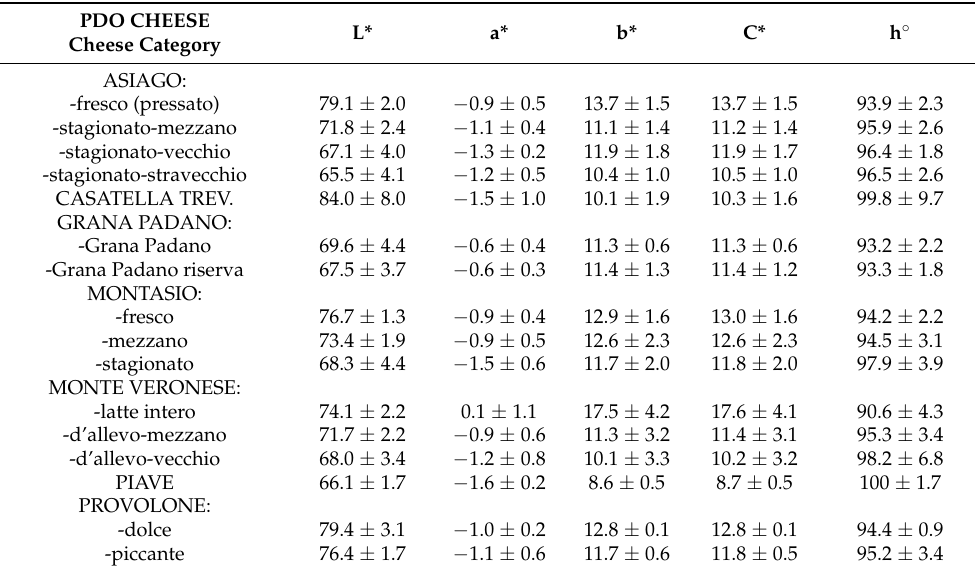
Table 7. Color traits 1 of the paste of the cheeses with EU Protected Designation of Origin (PDO) status (averages and standard deviations by cheese category).